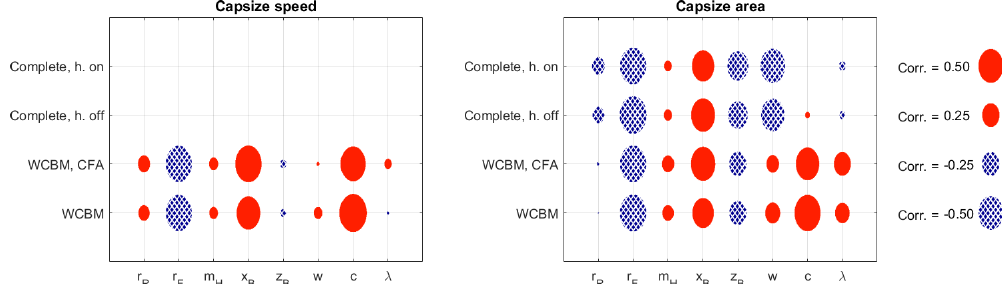
Figure 12. Correlation coefficients for the indices of the capsize mode. Models of increasing complexity from bottom to top. Speed range: 0 to 10ms − 1 .